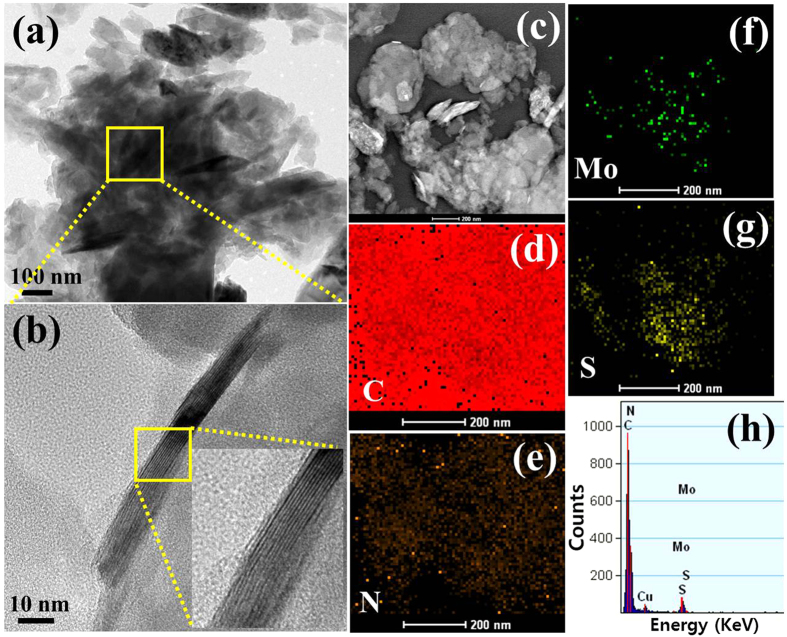
(a and b) TEM images of the MoS2-g-C3N4-1 at different magnification scale, (c–g) scanning transmission electron microscopy elemental mapping, and (h) EDX of the MoS2-g-C3N4-1.